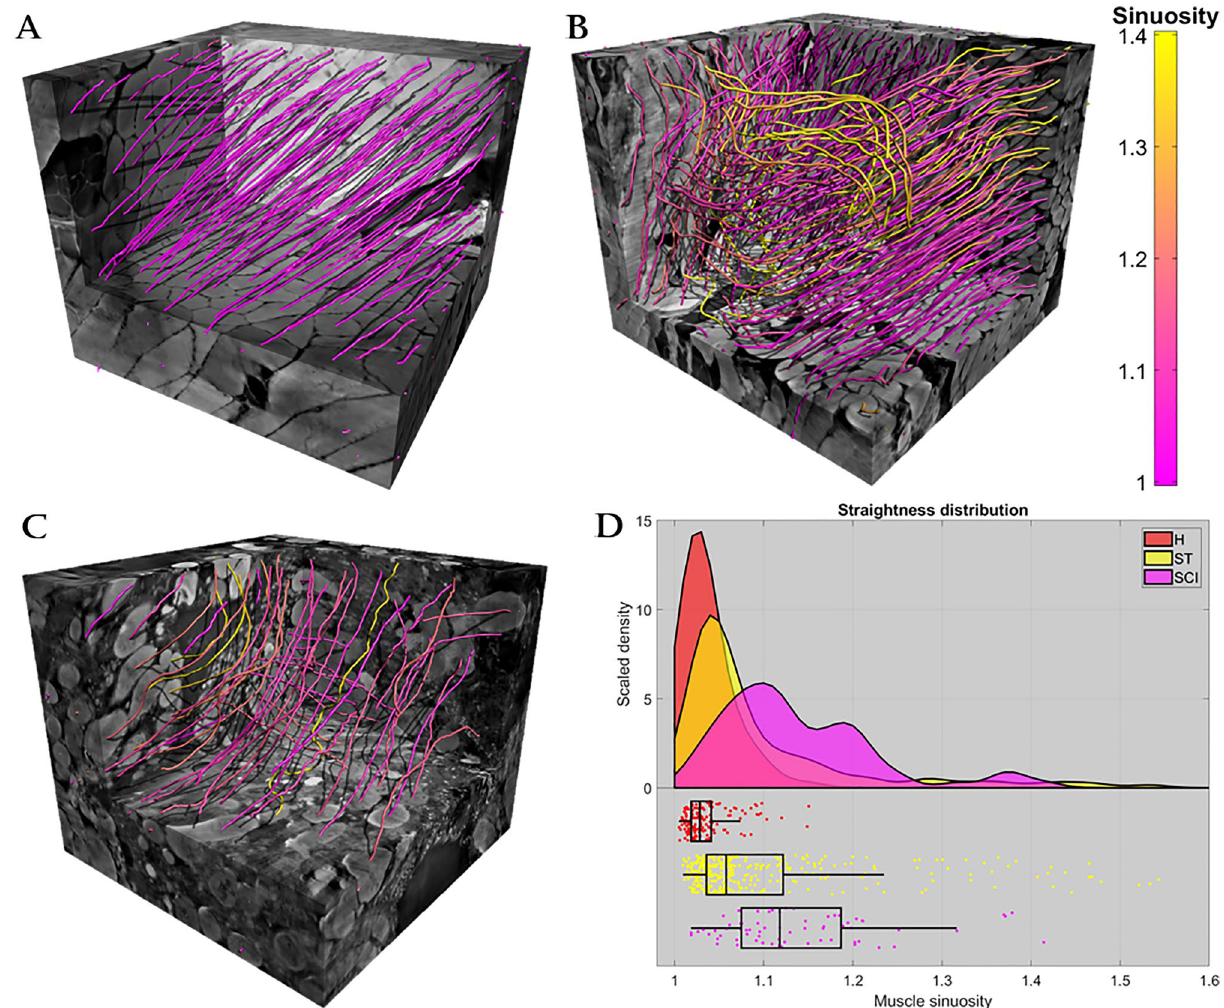
Figure 4. Analysis of muscle fiber straightness. ( A – C ) The detected centerlines within each of the three sample volumes, respectively in ( A ) the healthy control sample (H), in ( B ) the stroke sample (ST), and in ( C ) the spinal cord injury (SCI) sample. Each centerline is colored according to its sinuosity using the given color bar. ( D ) The statistics of centerline sinuosity for each sample. The distributions are a result of a kernel density estimation 53 . The boxplots indicate median value, 1st and 3rd quartile, and the whiskers are 1.5 IQR or truncated at extremum value. The figure was created using MatLab software (v2020b): https:// www. mathw orks. com/ produ cts/ new_ produ cts/ relea se202 0b. html and Blender software (v2.78c): https:// www. blend er. org/ downl oad/ relea ses/2-